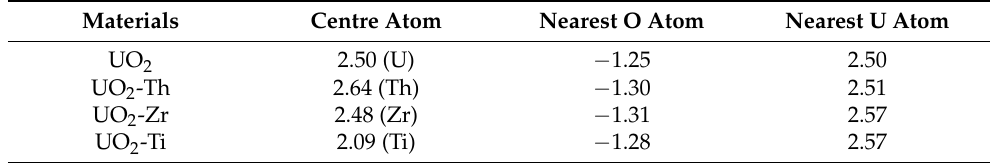
Table 3. Atomic Bader charges (|e|) of pure UO 2, and Th, Zr, and Ti substituted U defect UO 2 system.